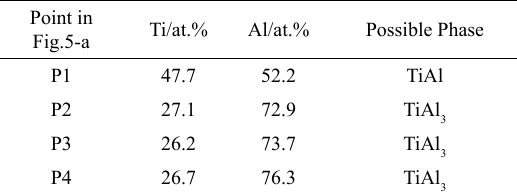
Table 2. Composition and phase of various regions from Fig.8-c. Point in Ti/at.% Fig.5-a